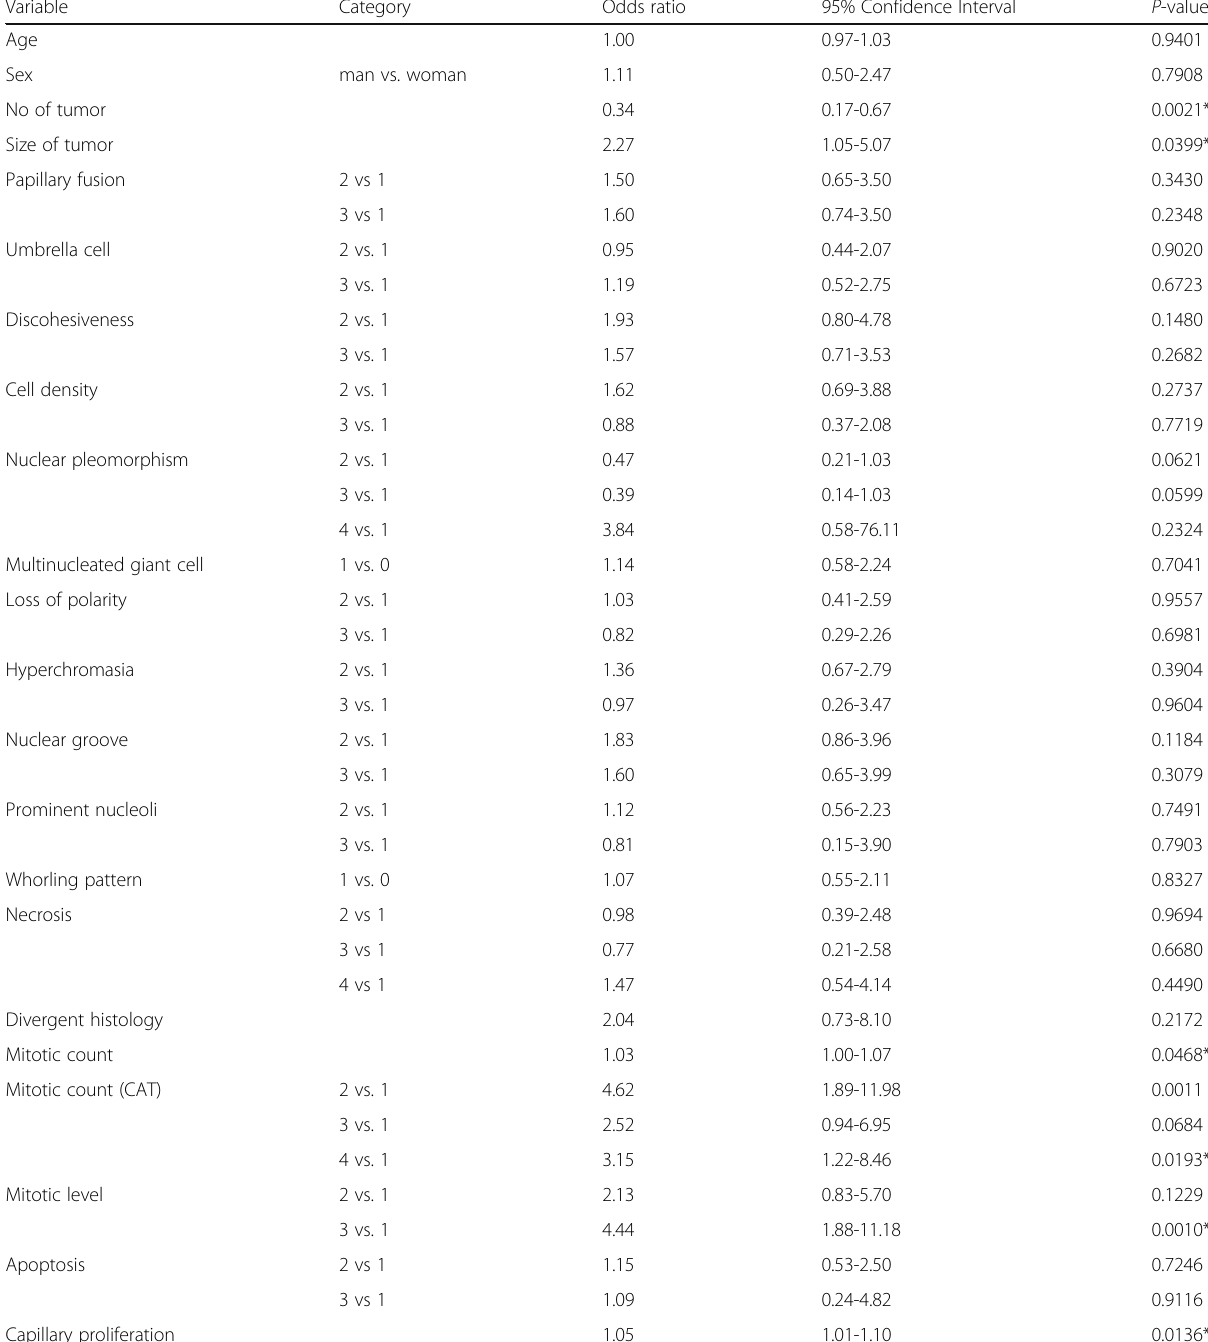
Table 3 Univariate analysis of factors associated with recurrence of PUC-Ta Variable Category Odds